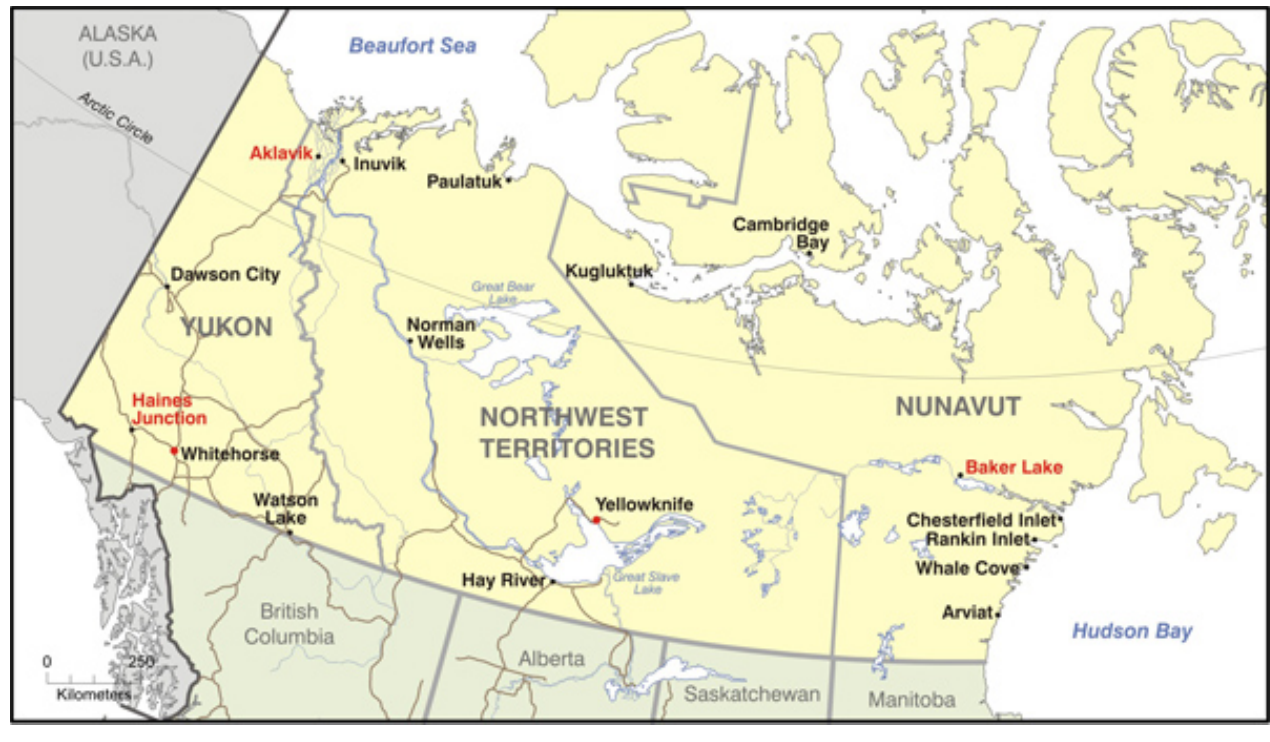
Fig. 1. Location of the study sites (indicated by red lettering) in relation to other communities and geographical features in northern